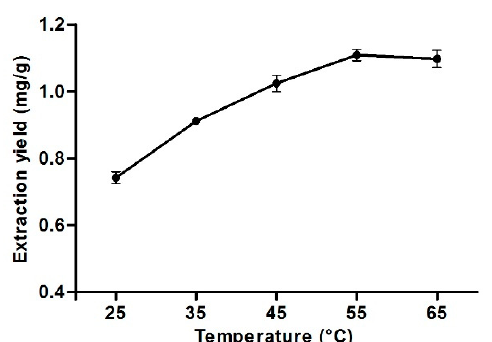
Figure 8. Effect of temperature on the extraction yield of rutaecarpine. La-Buta DES aqueous solution with 1:0.5 molar ratio containing 25% water was used as a solvent to extract at a solid-liquid ratio of 1:50 with ultrasound at different temperatures and 500 W for 40 min. The data represent mean ± S.D. of triplicated experiments.